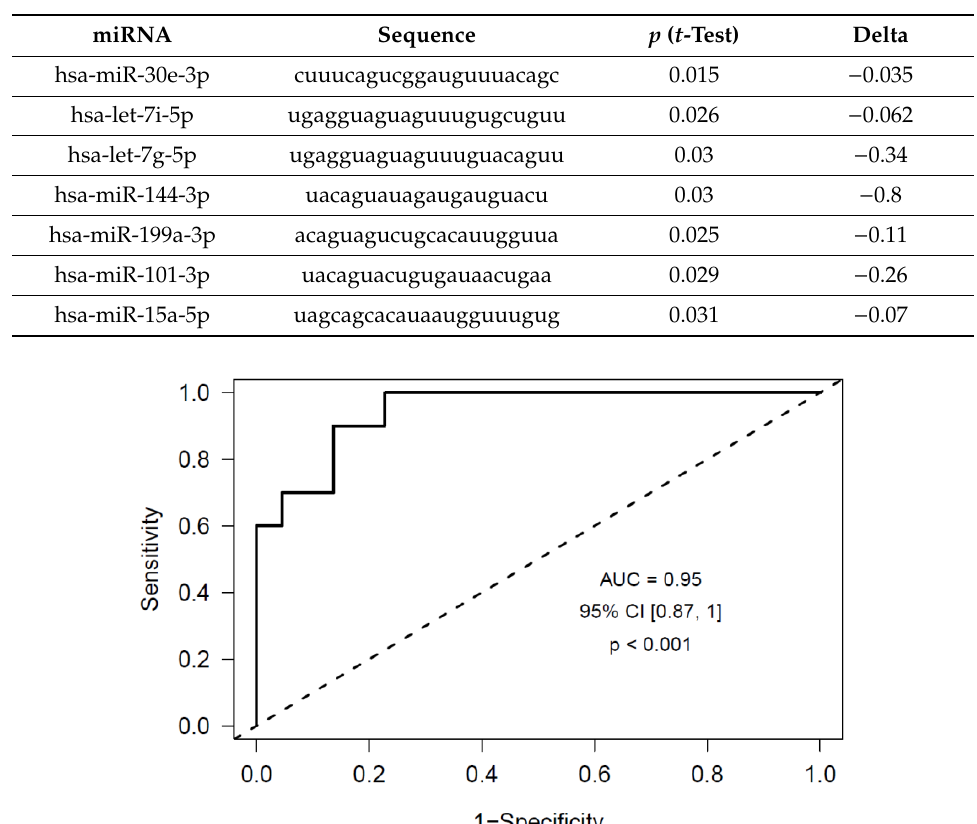
Table 3. Dysregulated miRNAs in PDAC and DECC patients who develop a VTE during follow-up, comparing the sample at inclusion and that right before the VTE event. miRNA sequences according to miRBase 22.1. Delta is defined as the di ff erence of the average expression level of a miRNA between the samples at inclusion and the ones right before the VTE event. The negative values of delta represent down-regulation of miRNAs in the samples right before the VTE event.